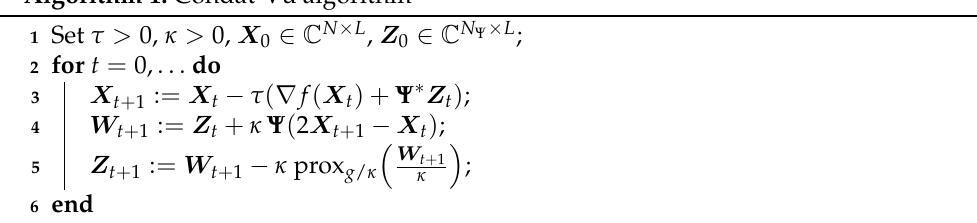
Algorithm 1: Condat-Vú